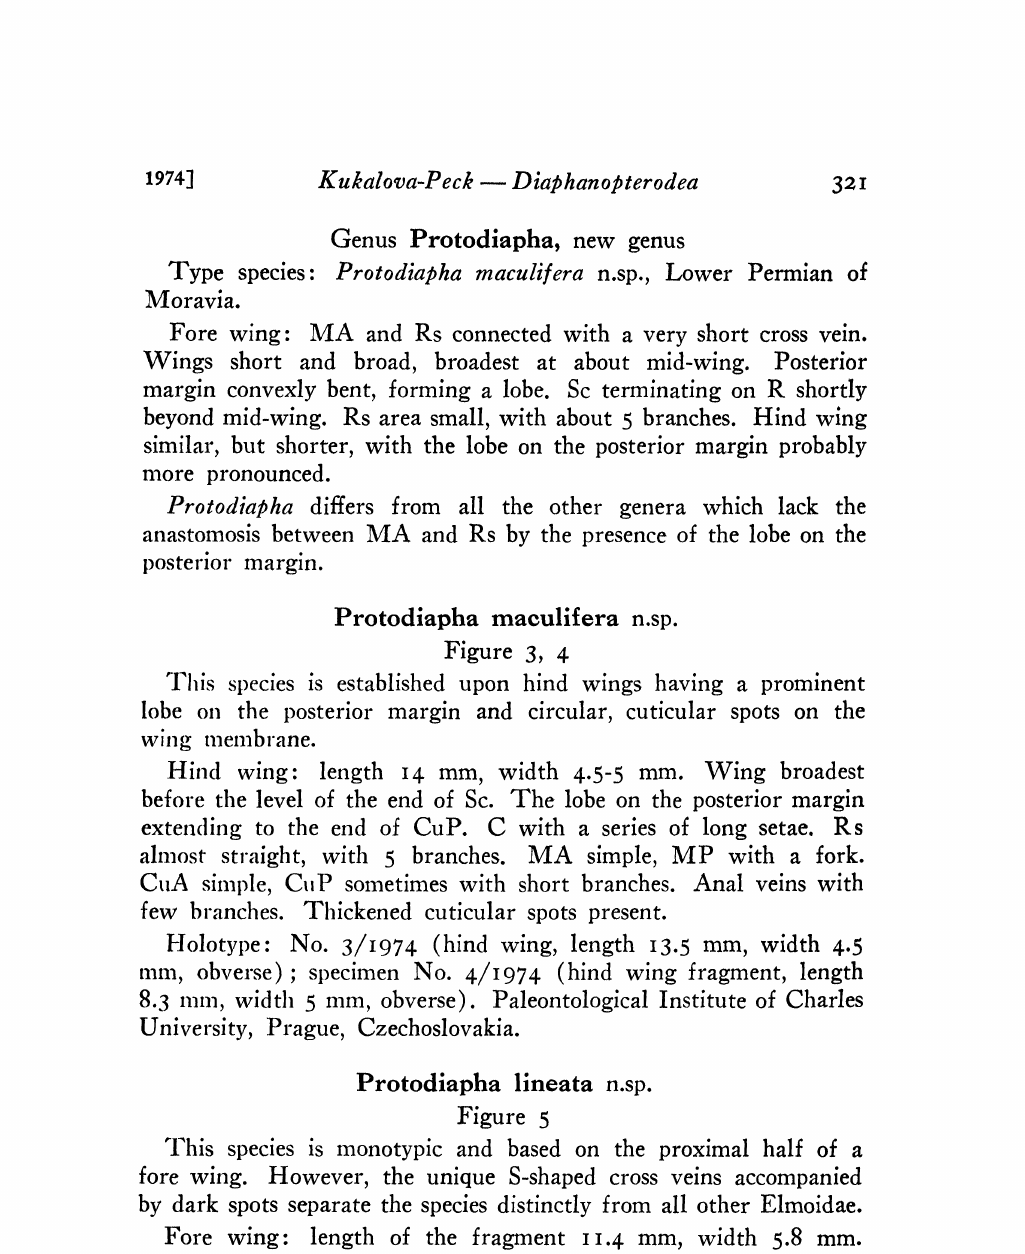
Cross veins long, S-shaped, surrounded by dark spots. Circular cuticular spots